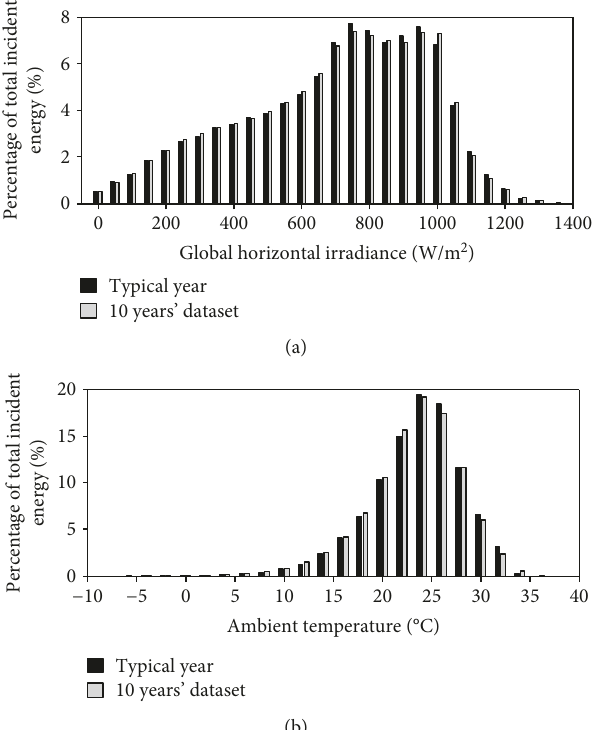
Figure 1: Comparison of annual histograms of global horizontal irradiance (a) and ambient temperature (b) between the generated typical year and the 10 years ’ dataset.